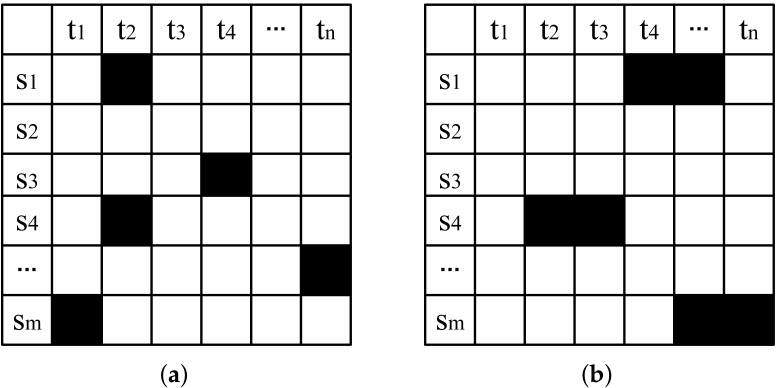
Figure 1. Missing characteristics of regional traffic flow data. (Black squares indicate missing data.) ( a ) The flow is missing randomly within the area; ( b ) missing flow in the continuous time domain within the